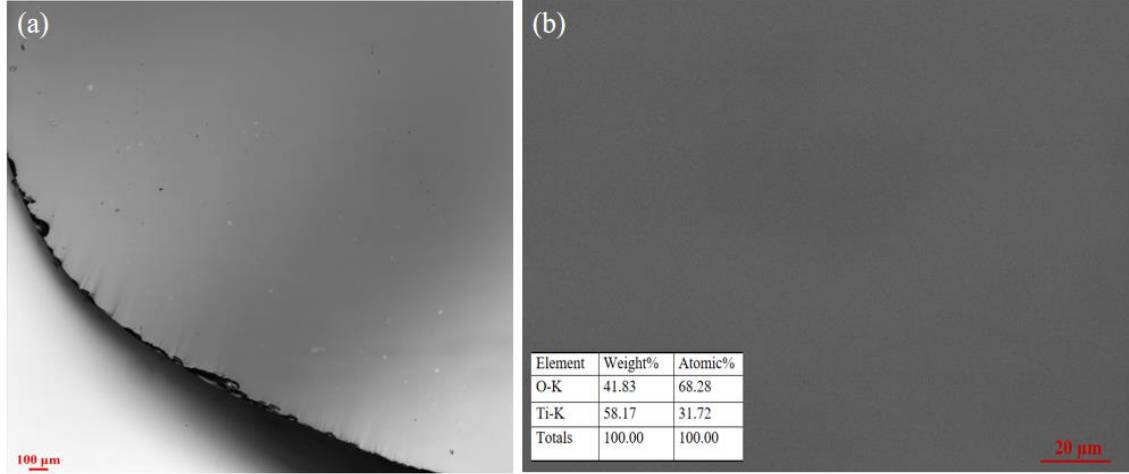
Figure 5. ( a ) Morphology of the sample after being polished and ( b ) SEM image.